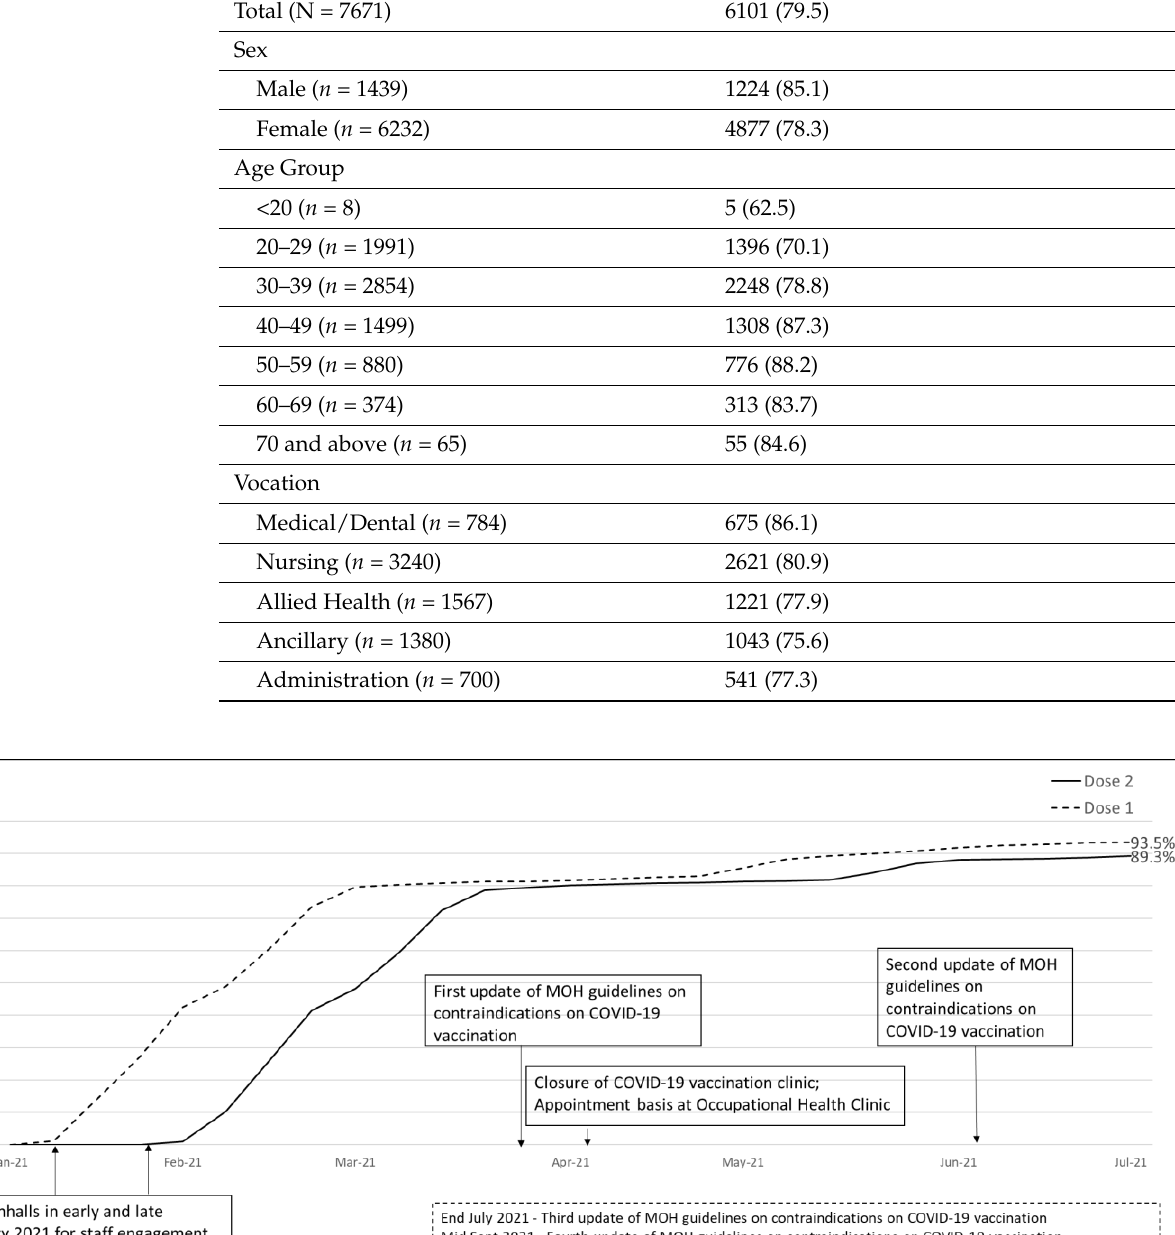
Table 2. Demographics of fully vaccinated staff by late March 2021.